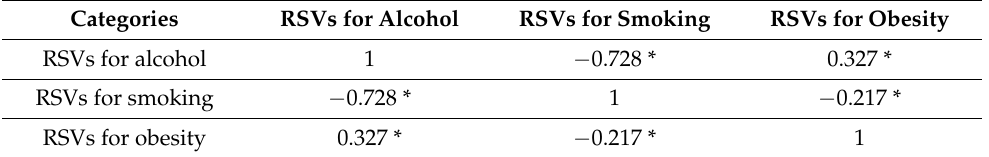
Table 2. Correlation coefficients between the relative search volumes (RSVs) related to the obesity-, alcohol-, and smoking-related search terms registered during the study